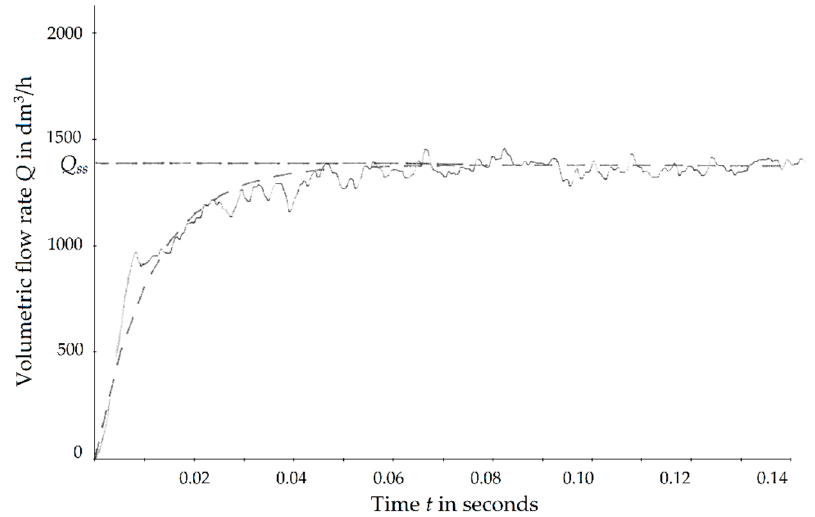
Figure 3. Step change registered by hot wire anemometer (solid line) and its approximation (dashed line).